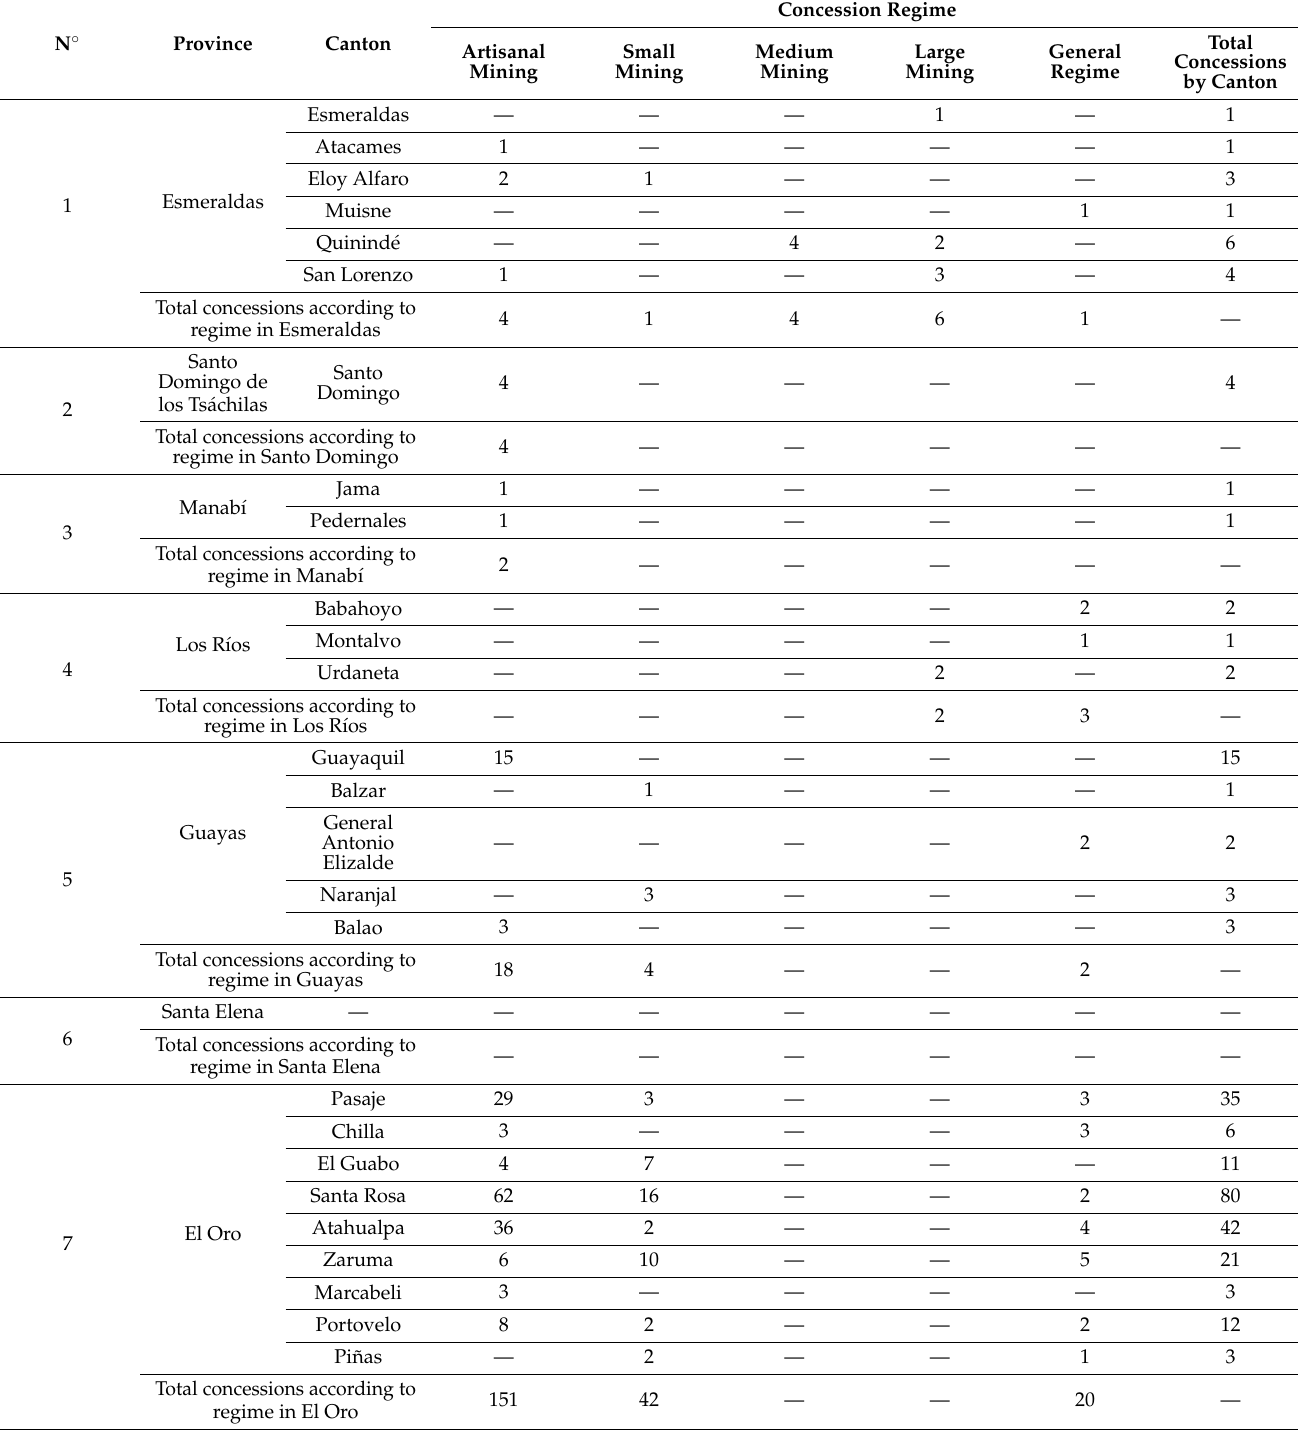
Table 1. Gold mining concessions in the Litoral